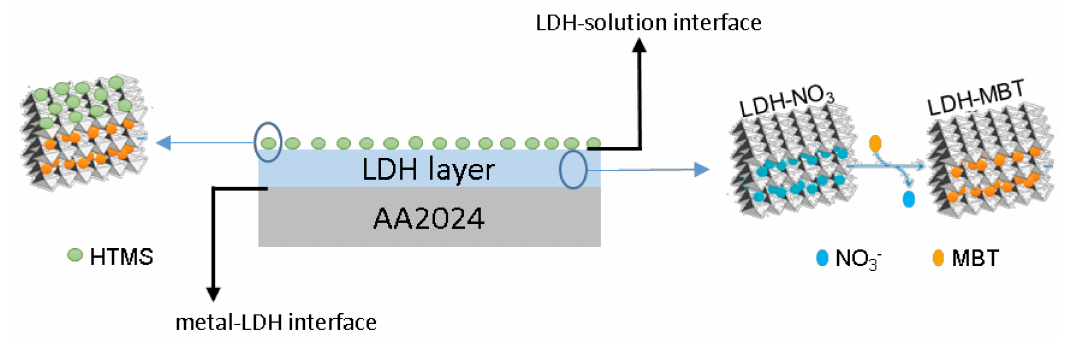
Scheme 1. Representation of SR-LDH nanostructured layer with intercalated corrosion inhibitor and surface modified on AA2024